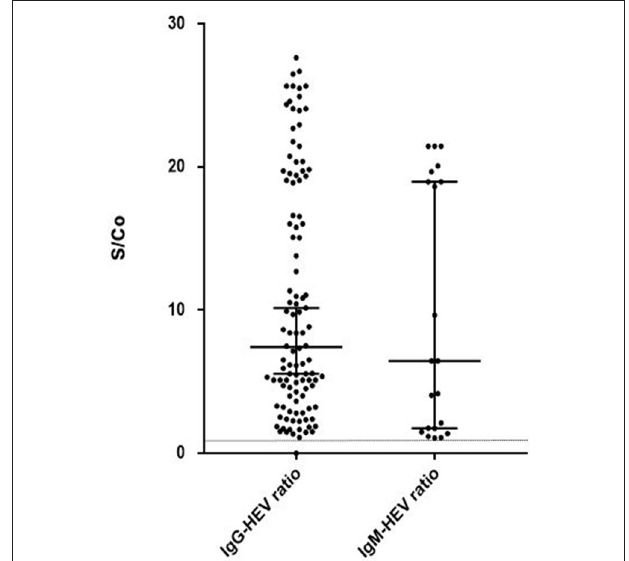
FIGURE 2 | HEV IgG and IgM ratio (S/Co) in positive samples (S/Co:signal-to-cut-off ratio). Limit of positivity is plotted on the vertical axis with the dotted